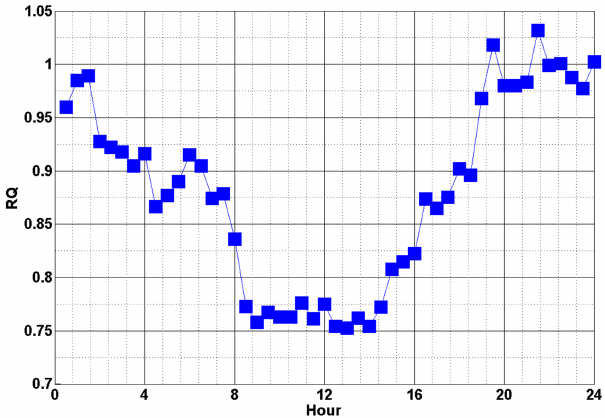
Figure 6. The applied RQ value in a day